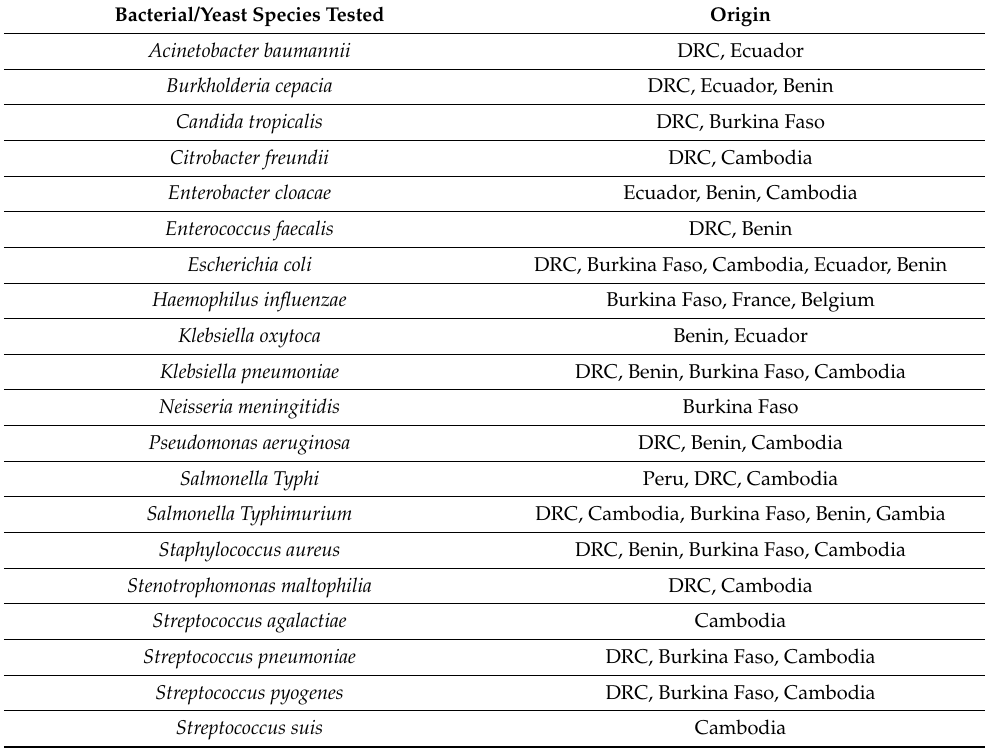
Table A2. List of bacterial species used in the reference validation study and their